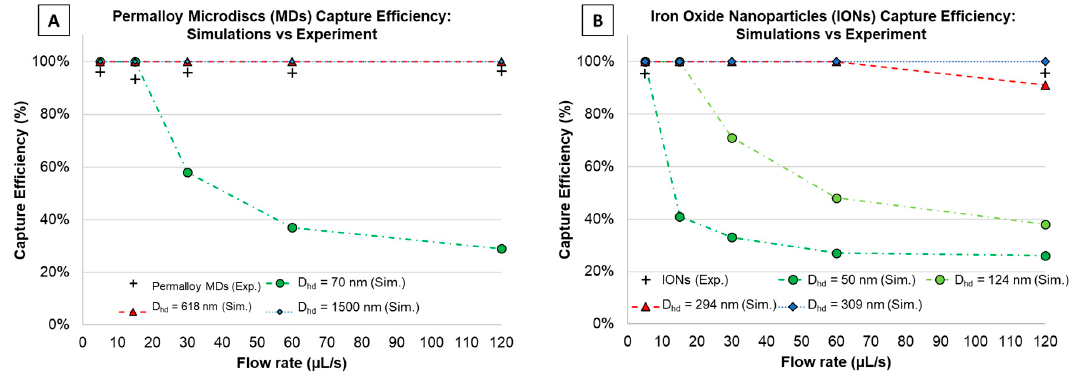
Figure 5. Capture e ffi ciency study for ( A ) microdiscs and ( B ) iron-oxide nanoparticles (experiments and COMSOL simulations).